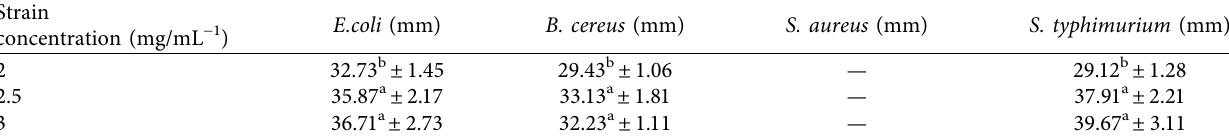
Table 6: Te antibacterial circle diameters of casein hydrolytes released by diferent concentration. Strain concentration (mg/mL − 1 )